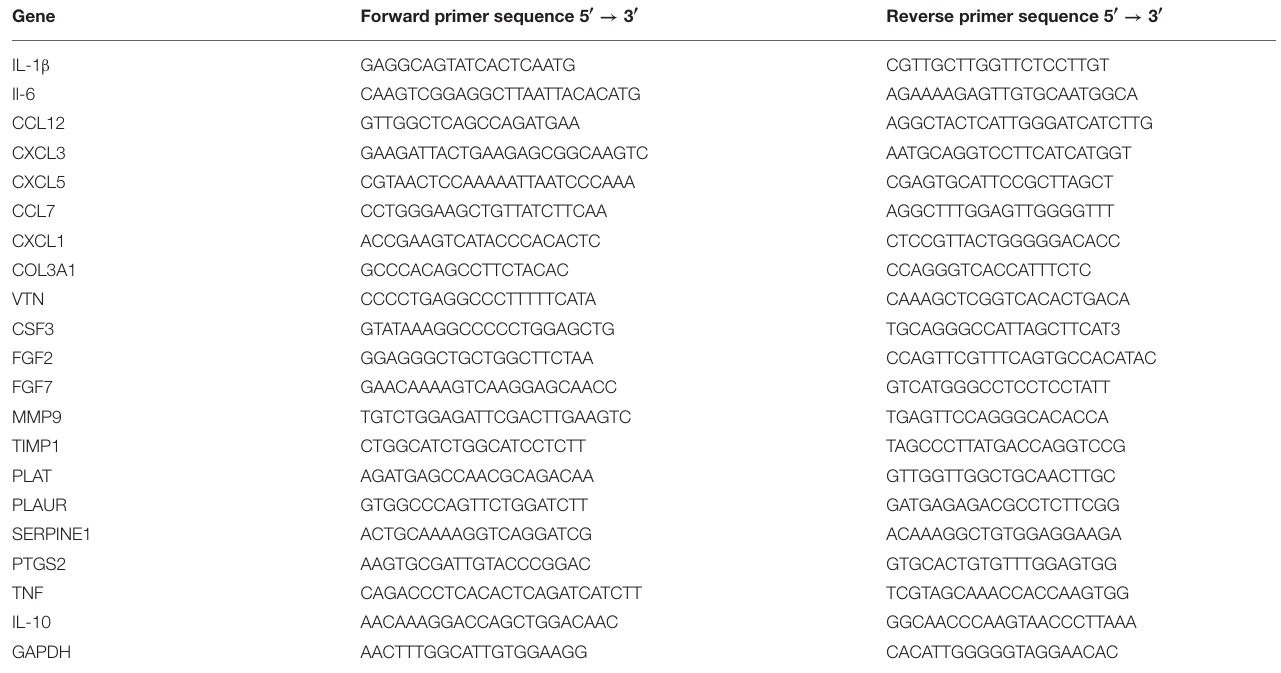
TABLE 1 | List of murine primers used in RealTime PCR. Gene Forward primer sequence 5 ′ → 3